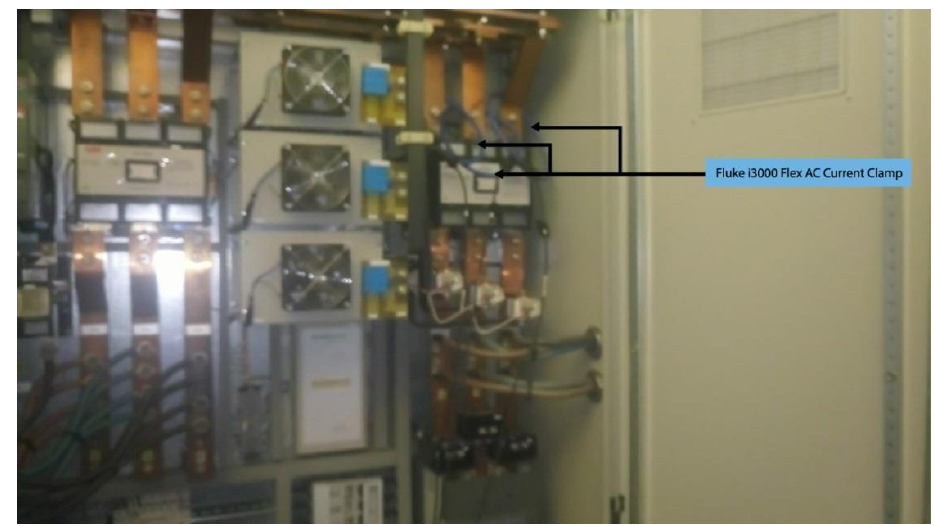
Figure 1. Location of the current clamps on the WT power panel.